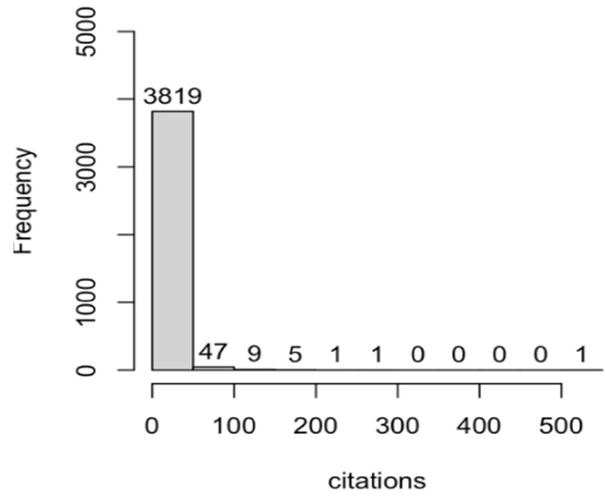
Figure 3. Histogram of citations.